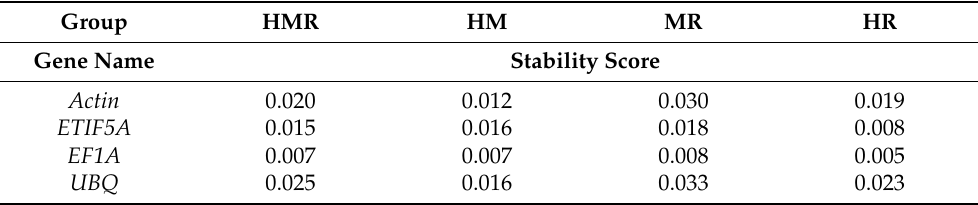
Table 3. Stability of the selected RGs in multiple flax cultivars. Stability scores of RGs were com- puted from the Ct values obtained from qRT-PCR data of drought stressed flax plants by using NormFinder. The groups are the combination of flax cultivar Hira-Mukta (HM), Mukta- R552 (MR), and Hira-R552 (HR), and Hira-Mukta-R552 (HMR).